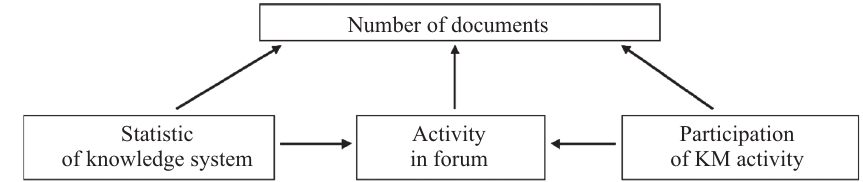
Fig. 3. The theoretical model of Employee Participation in